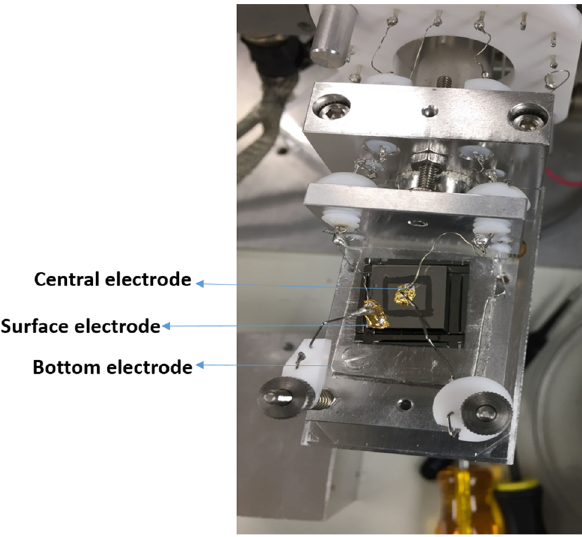
Fig. 4 A detector is loaded into a cryostat for I–V measurement at desired